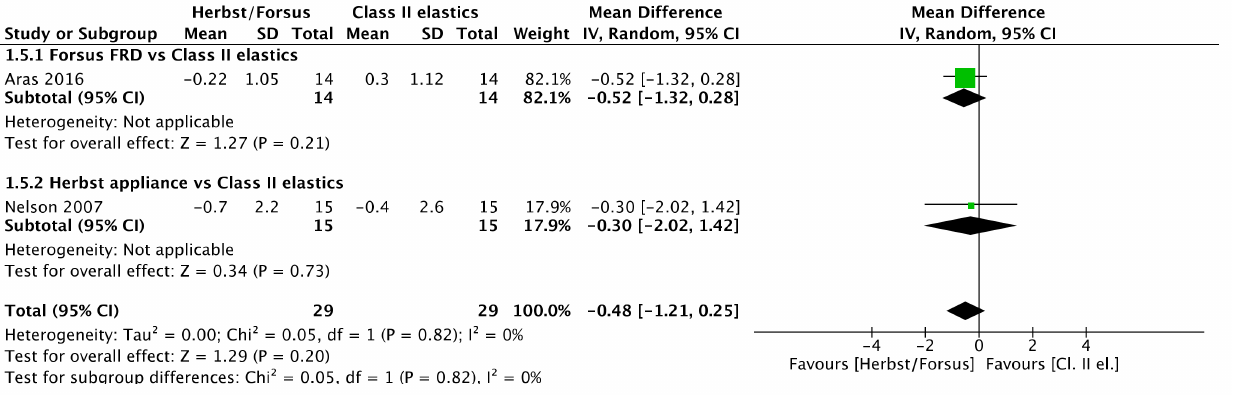
Figure 6. Forest plot of the SNA angle changes using the random effects model [39,46].